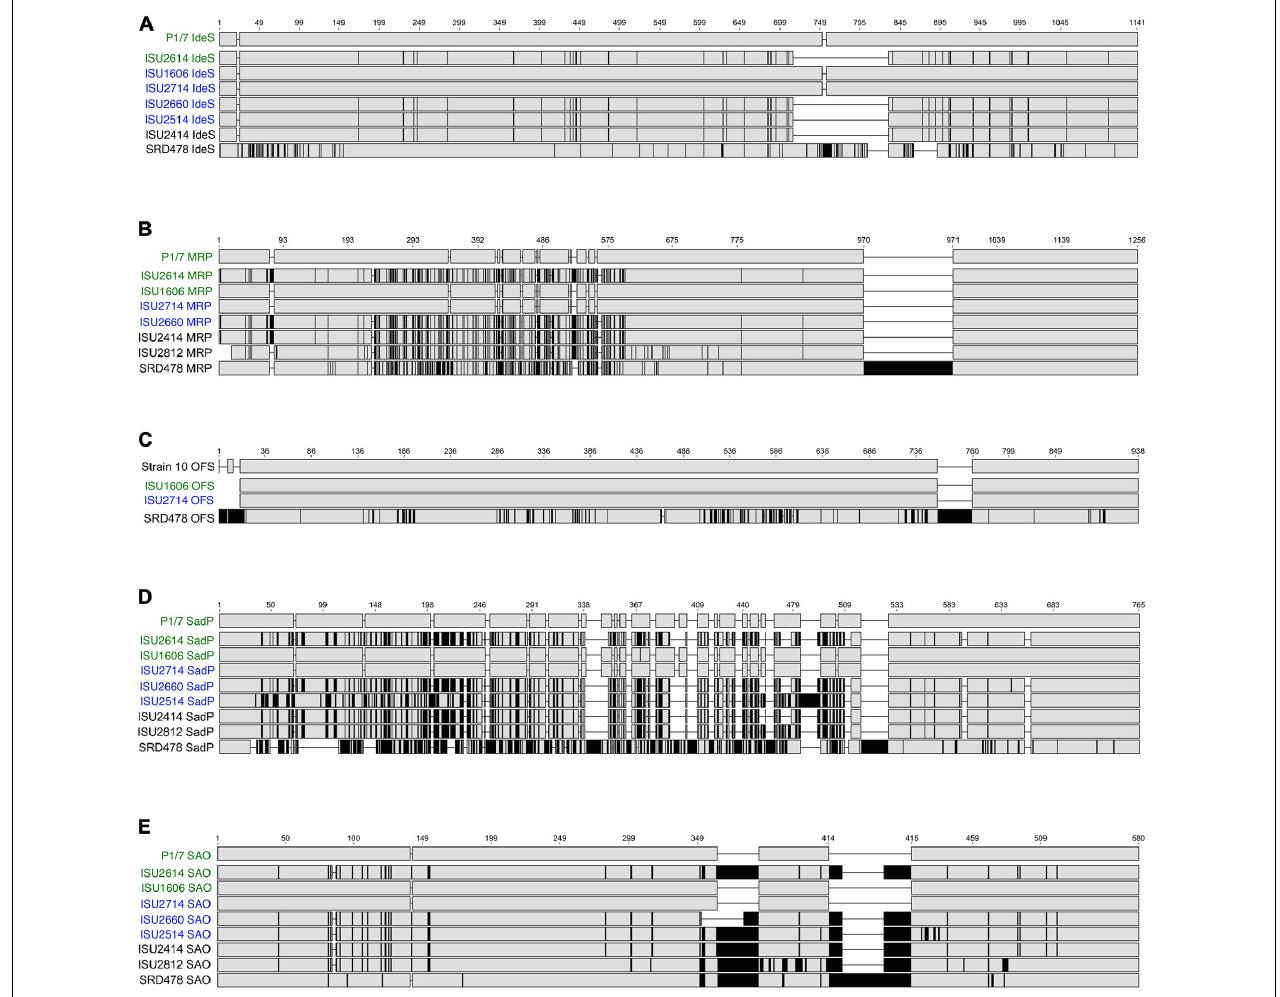
FIGURE 7 | Protein sequence alignments. Gene sequences were identified by BLASTn, translated, and multiple alignments of the protein sequences were created using MAFFT. Gray regions indicate identical amino acids, black regions indicate amino acid sequence differences compared to the reference (top) sequence. (A) Multiple alignment of IdeS (immunoglobulin M-degrading enzyme); P1/7 IdeS used as reference sequence. (B) Multiple alignment of MRP (muramidase-released protein); P1/7 MRP used as reference sequence. (C) Multiple alignment of OFS (serum opacity factor); Strain 10 OFS used as reference sequence. (D) Multiple alignment of SadP (cell wall adhesin); P1/7 SadP used as reference sequence. (E) Multiple alignment of SAO (surface antigen one); P1/7 SAO used as reference